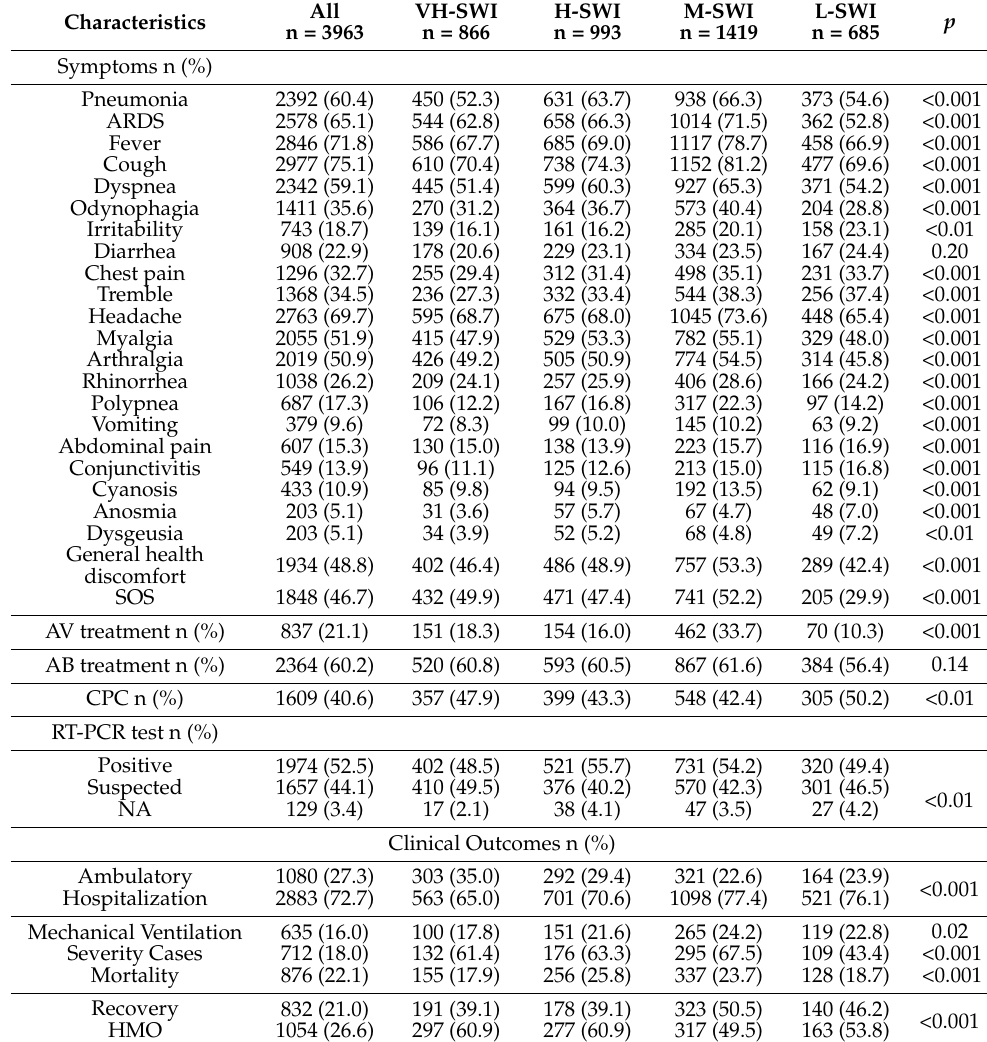
Table 2. Epidemiological-clinical profile, treatment and outcomes of total sample and by Social Welfare Index categories of patients with COVID-19 clinical